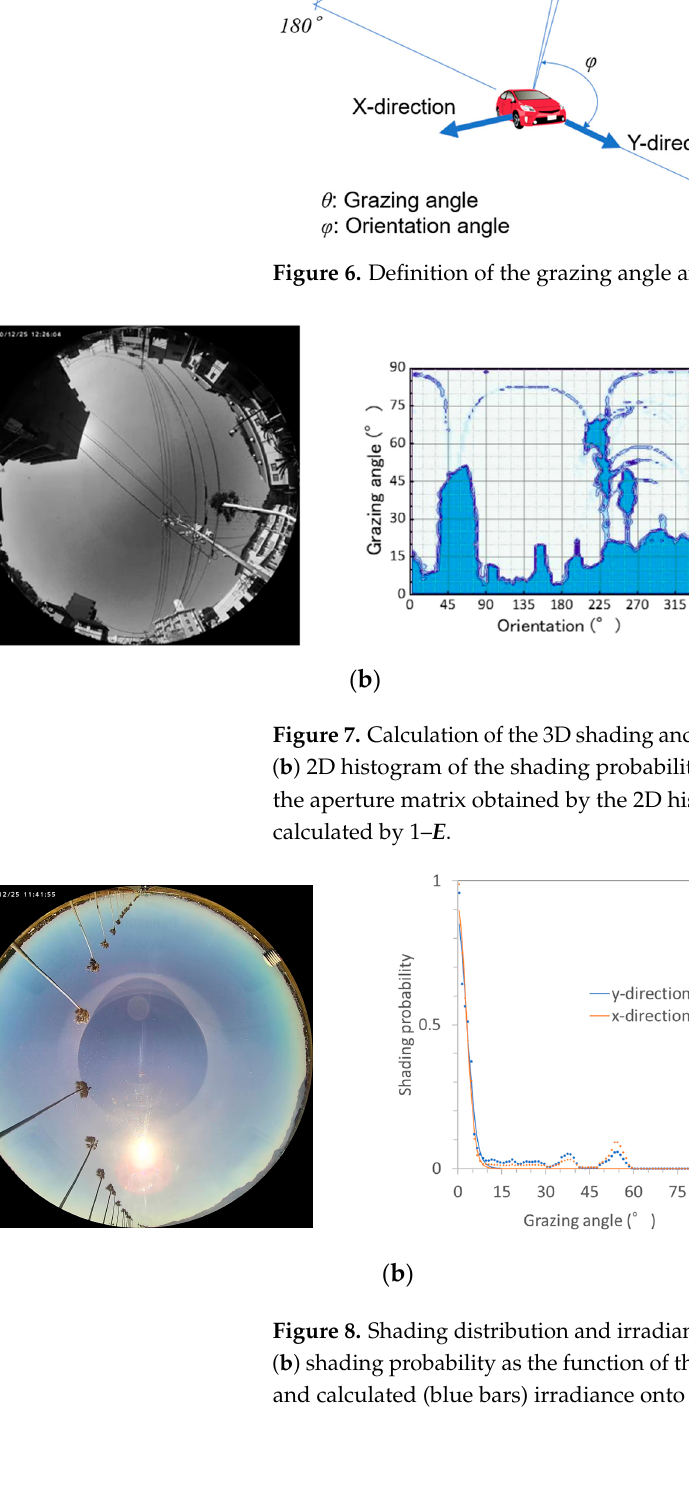
Figure 9. Shading distribution and irradiance onto VIPVs (5-axis) of the residential zone: ( a ) fi sheye image; ( b ) shading probability as the function of the grazing angle; ( c ) comparison of the measured (red bars) and calculated (blue bars) irradiance onto 5-axis planes.